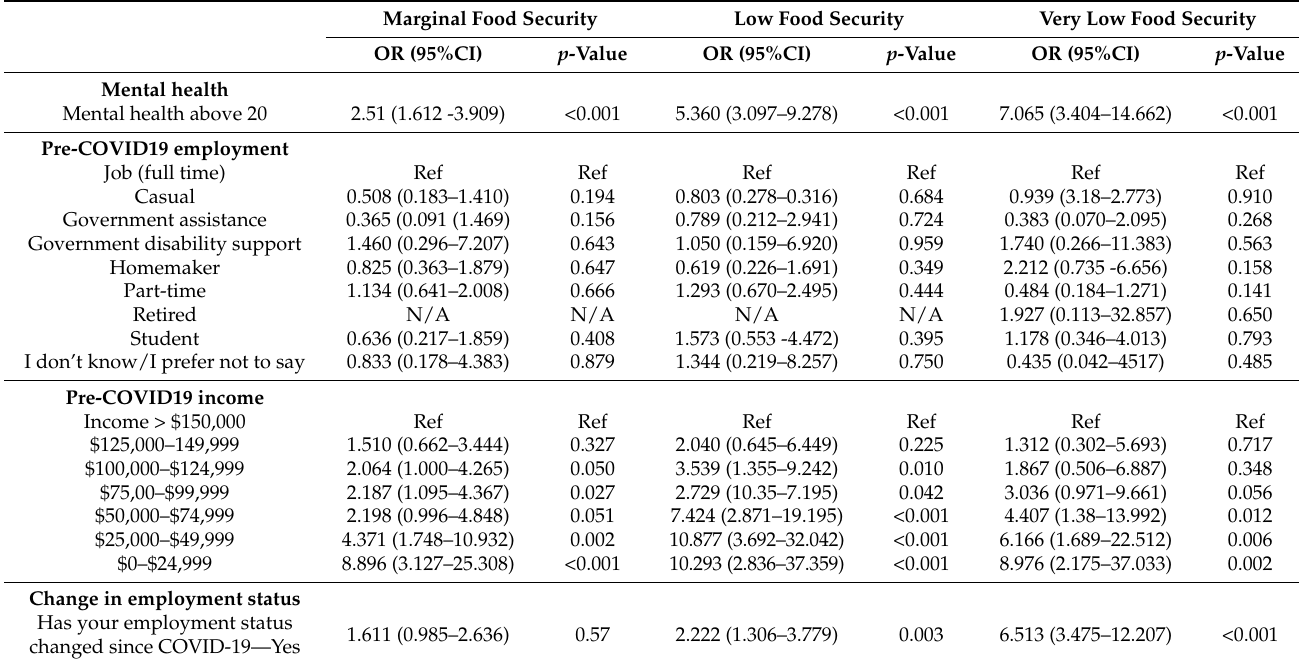
Table 3 footnotes: All ORs are in reference to high food security. Covariates included in the model: State, marital status, children, education, pre- COVID-19 employment, pre COVID-19 income and change to employment status due to COVID-19. Abbreviations: Ref = reference, OR = odds ratio and 95%CI = 95% confidence interval. N/A represents results that were unable to be displayed due to low respondent